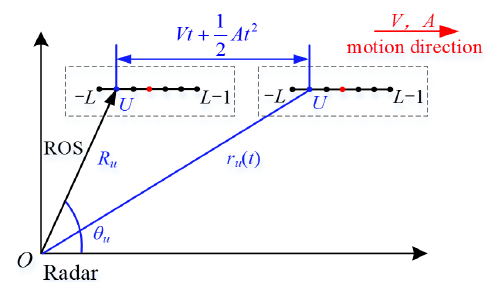
Figure 3. Schematic diagram under the case that the target does not